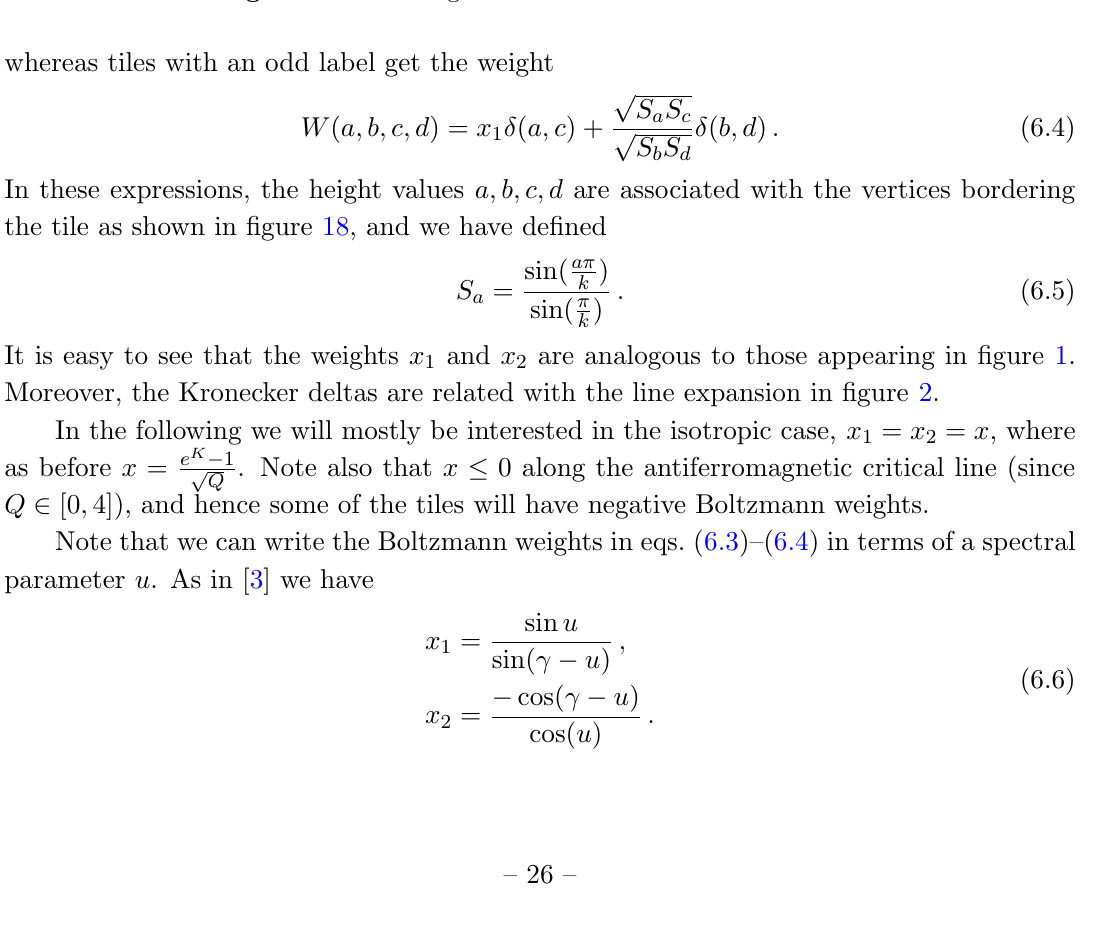
Figure 17 . The staggered RSOS model. An integer heights lives on each vertex, here shown for a lattice of width N = 2 L = 6. The numbers on the centre of the tiles are labels; in the staggered model, even and odd numbered tiles get di(cid:11)erent Boltzmann weights. When we pick the boundary heights h 1 = 1 and h N +1 = 1 + l , this RSOS model produces the string function c 0 the continuum limit. bc d a Figure 18 . Four heights around a tile in the RSOS